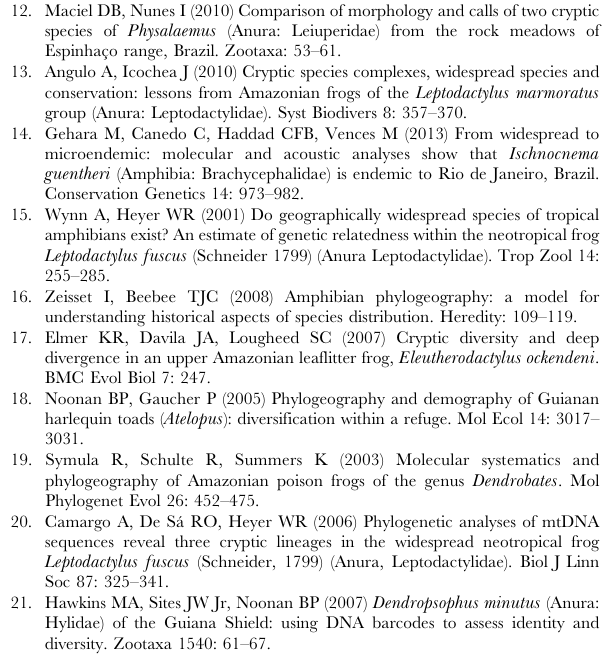
Table S2 Species used in the substitution rate estima- tion with respective Genbank accession numbers.